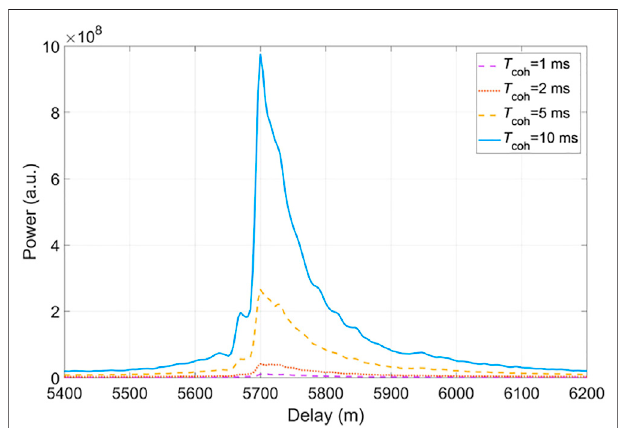
FIGURE 4 | Power waveform of airborne iGNSS-R under different signal processing time.